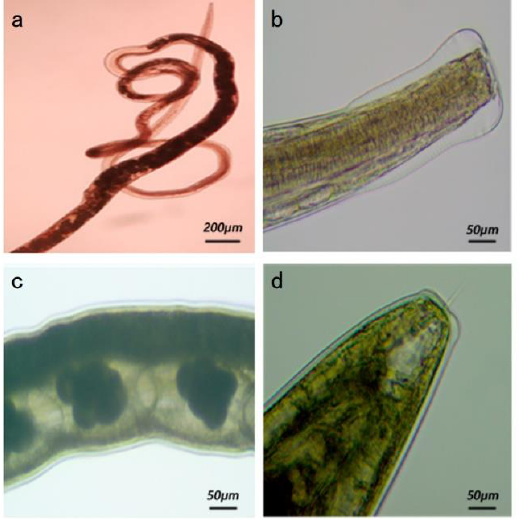
Figure 2. Morphology of adult Nematodirus spp. ( a ) Anterior segment of adult Nematodirus spp. (100 × ). ( b ) Head vesicle of adult Nematodirus spp. (250 × ). ( c ) Eggs in the uterus of a female Nematodirus spp. (250 × ). ( d ) A thin transparent thorn in the tail of a female Nematodirus spp. (250 × ).